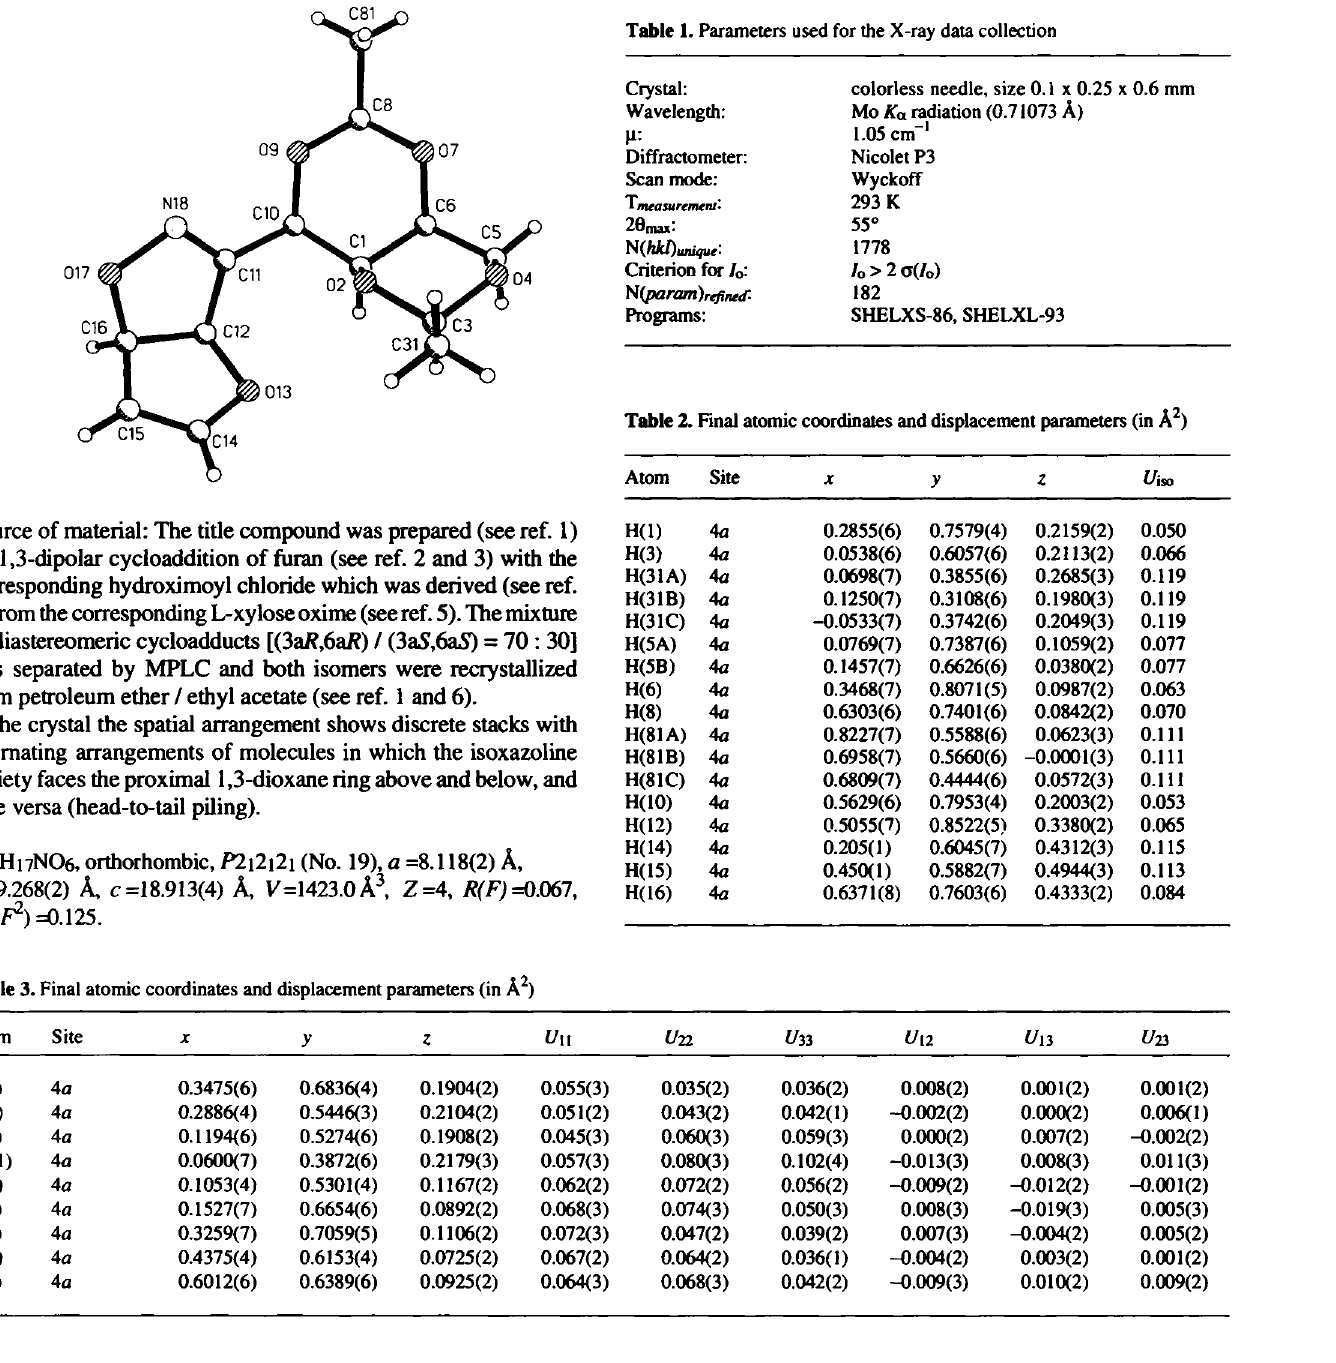
Table 1. Parameters used for the X-ray data collection